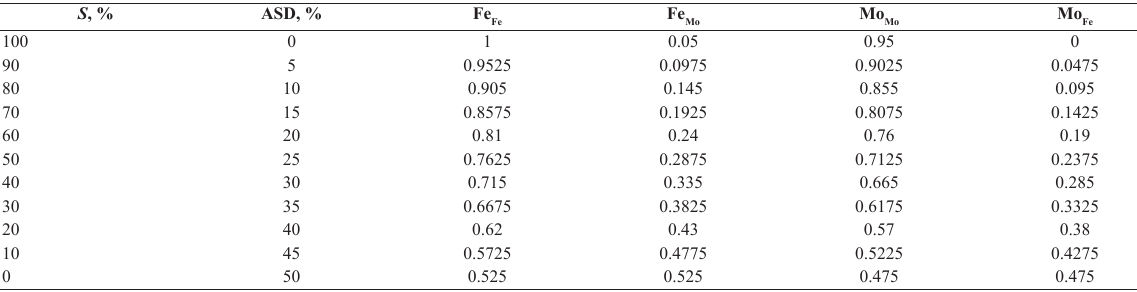
Fe Mo O sublattices. 2 1.05 0.95 6-δ